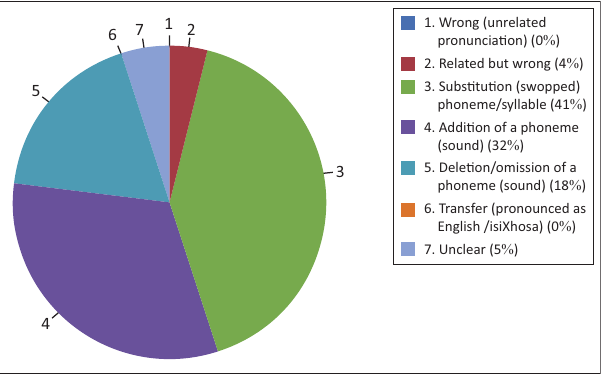
FIGURE 2: School E English pseudo-word reading ( n = 22). Mostly sublexical strategies.